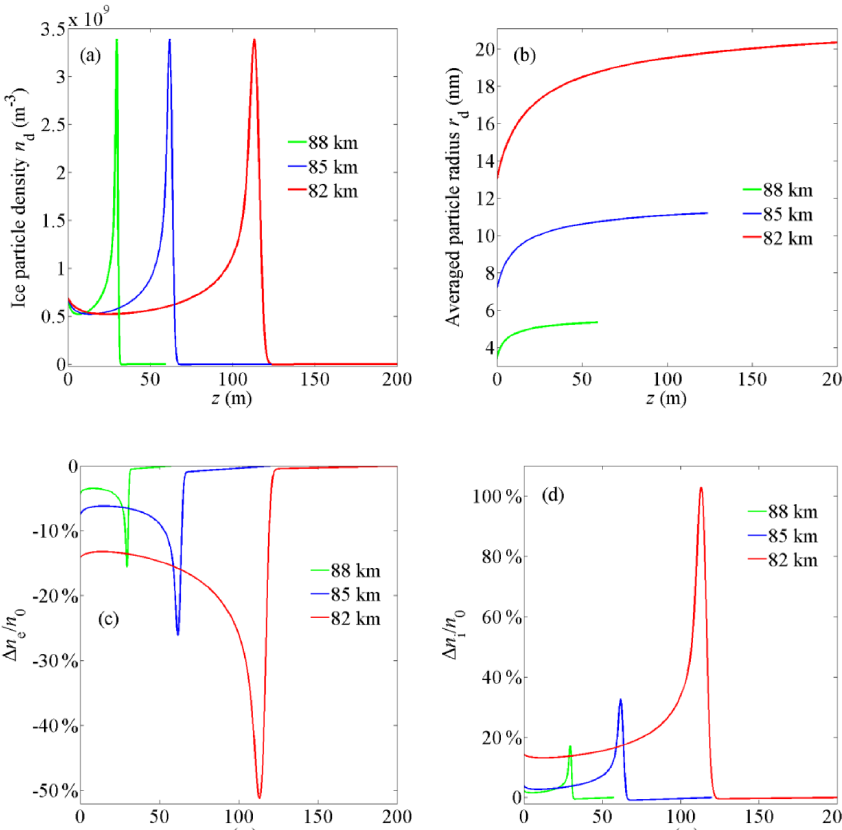
Figure 11. The distribution of (a) ice particle density, (b) the averaged particle radius, (c) the relative change of electron density (cid:49)n e /n e , and (d) the relative change of ion density (cid:49)n i /n i at various altitudes near the lower boundary of the condensation layer.